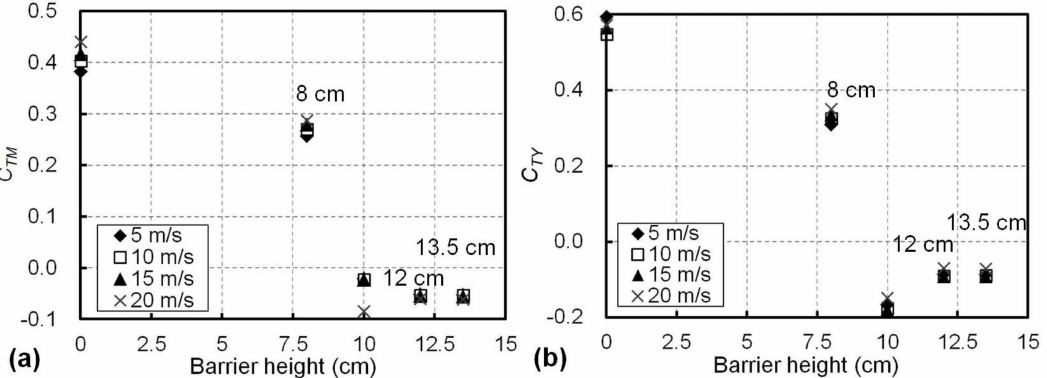
Figure 8. Aerodynamic responses of the train with di ff erent barrier heights at di ff erent airflow